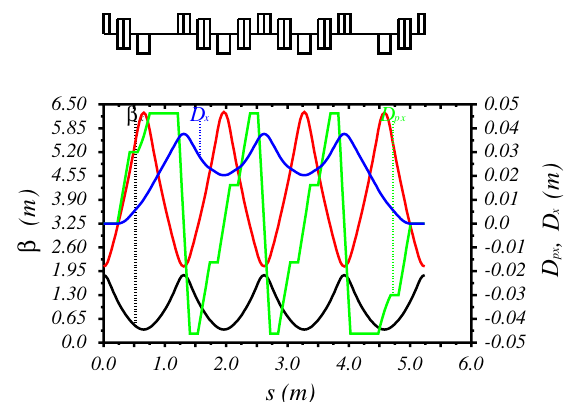
FIG. 4. First order dispersion and beta functions of one super- cell which consists of four FODO cells, under the missing dipole